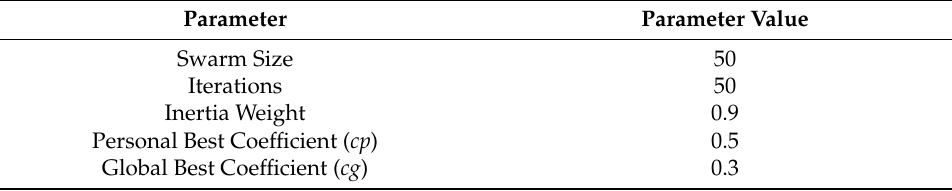
Table 1. The setting of PSO